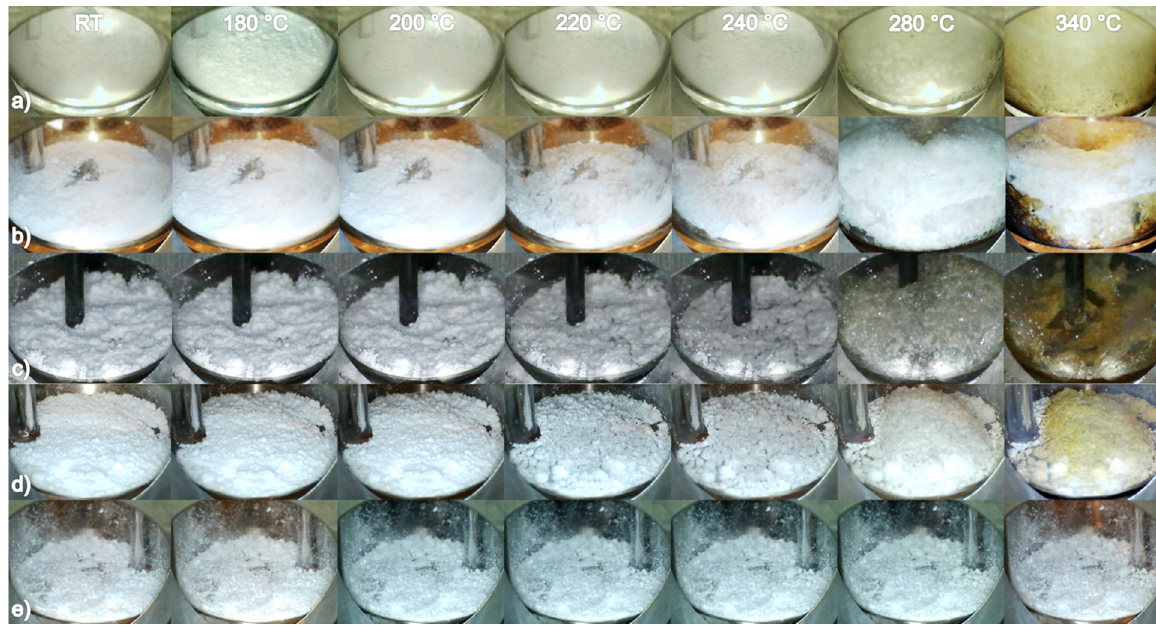
Figure 3. Temperature programmed photographic analysis (TPPA) sequence